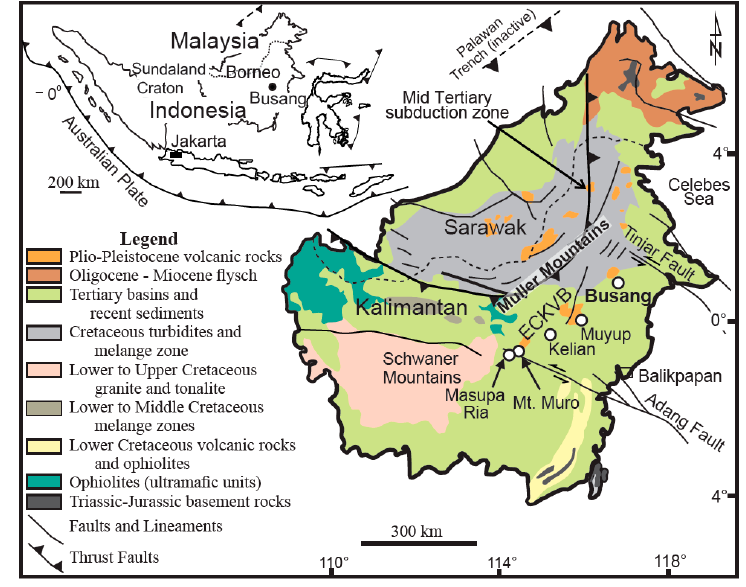
Figure 1. Location and geology of Borneo (after Hamilton [12], Moss and Chamber [15]) showing major structural elements and the East-Central Kalimantan Volcanic Belt (ECKVB) with its epithermal deposits (after Abidin [16]). Only Kelian (~75 Mt at 1.8 g/t Au) and Mt. Muro (10.4 Mt 3.8 g/t Au and 101 g/t Ag) became mines [17,18].